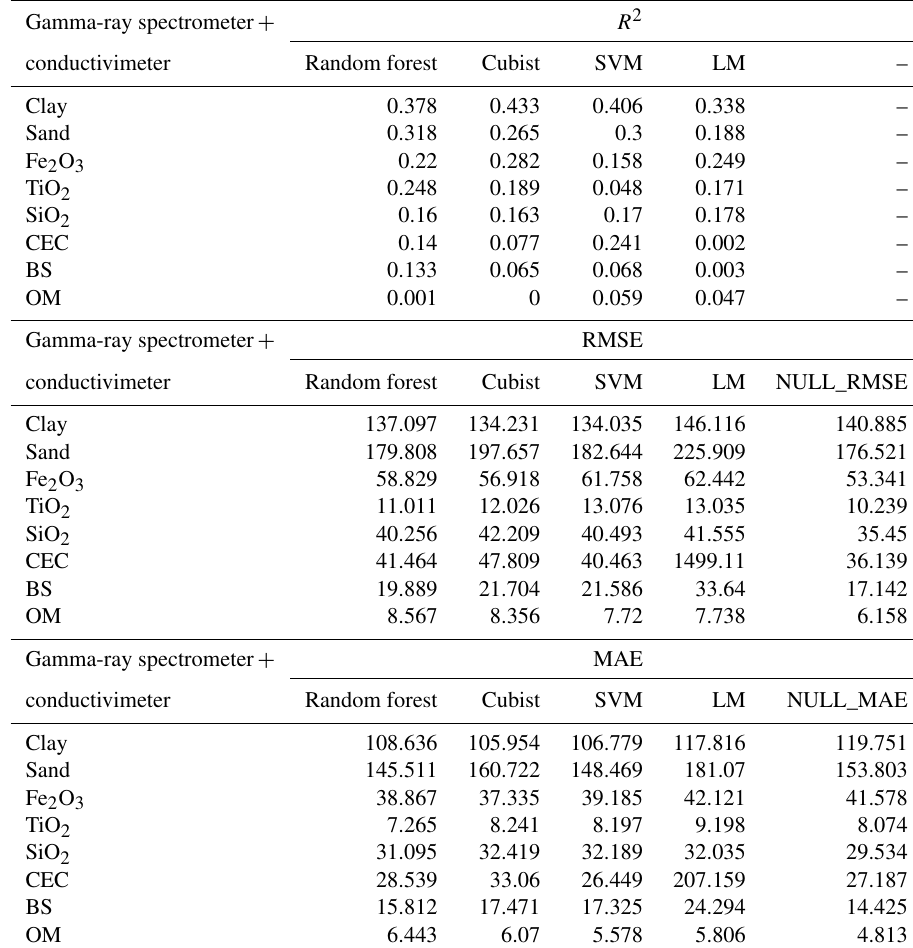
Table 4. Model performance for the combined use of gamma-ray spectrometer and the conductivimeter, for all soil attributes based on R 2 , RMSE, MAE, and